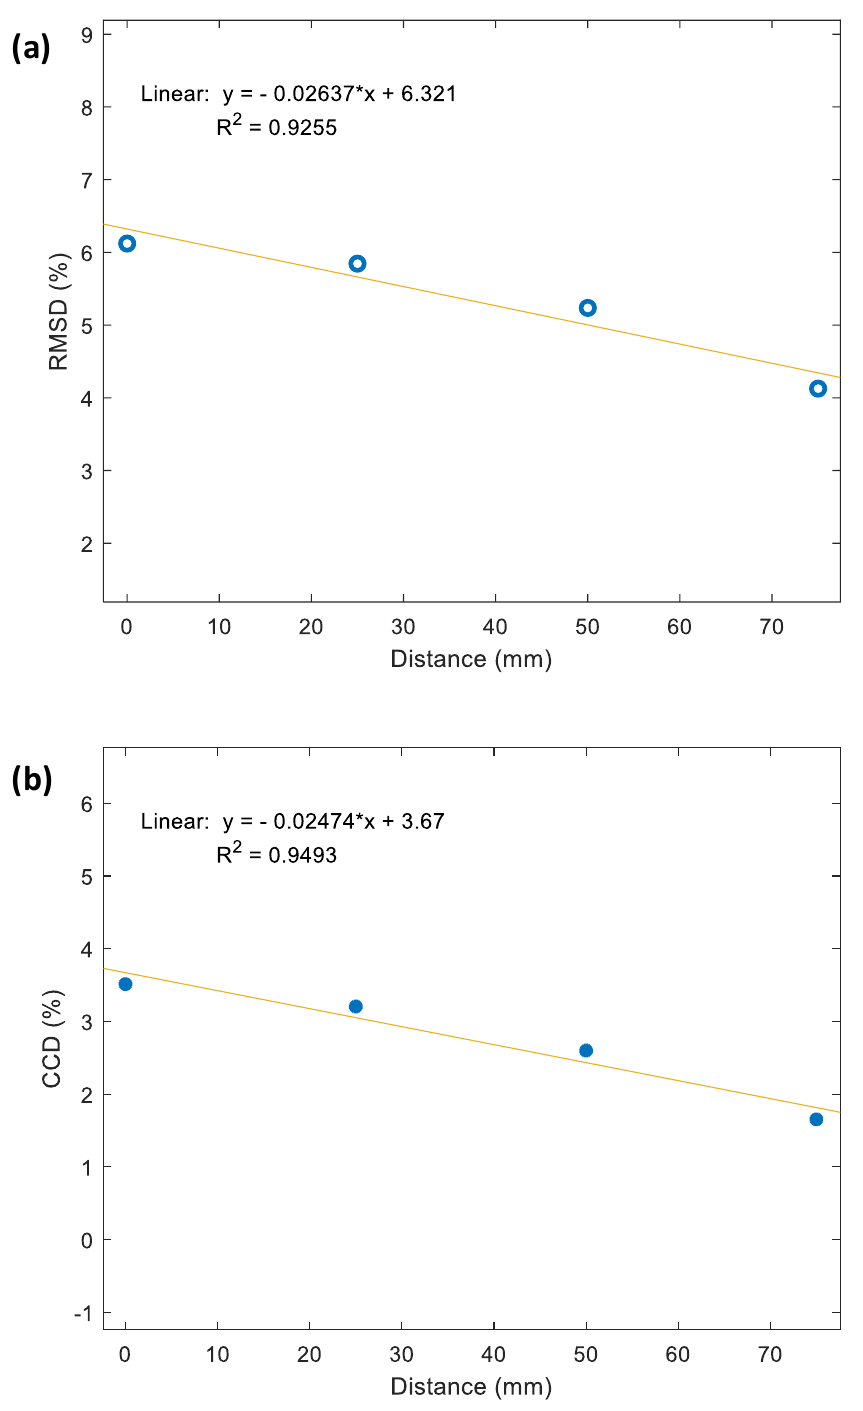
Figure 12. Linear regression analyses of the damage metric vs. the distance ( y ) for the vertical cracks: ( a ) RMSD metric; ( b ) CCD metric.